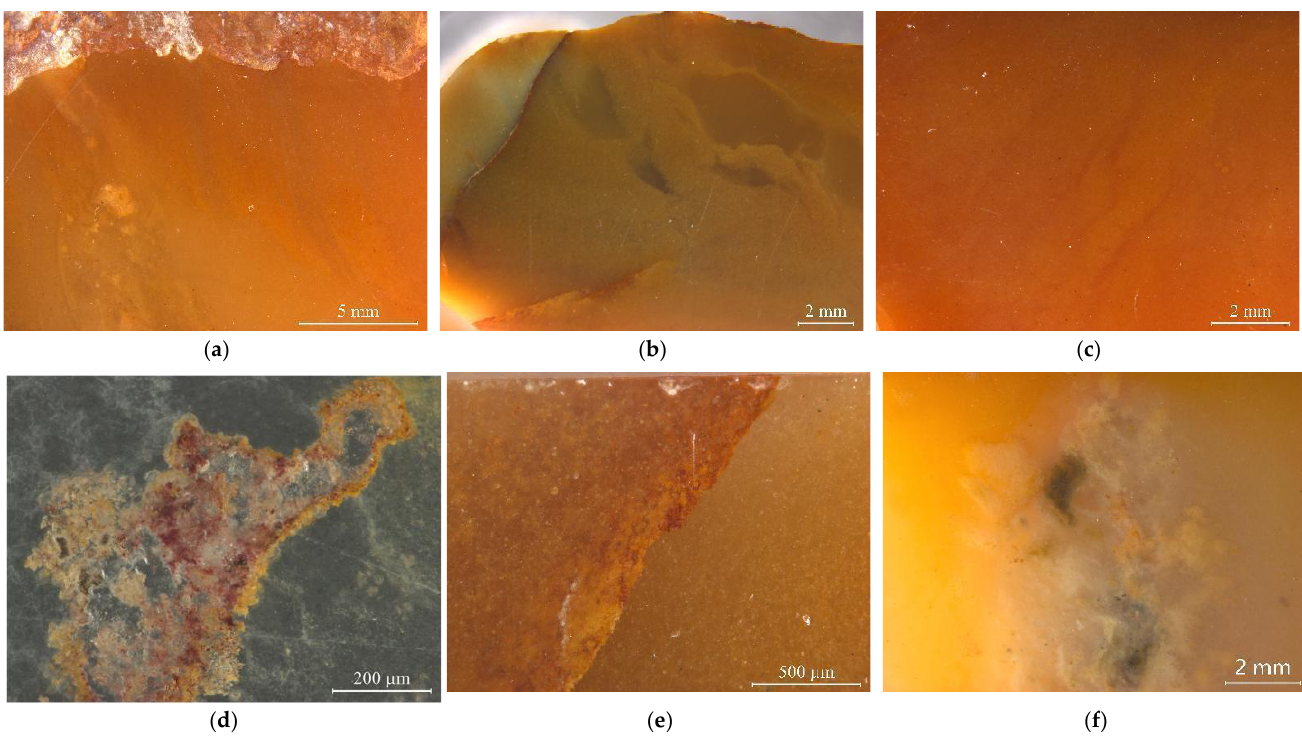
Figure 2. Colour distribution feature and impurity minerals in the samples. ( a ) orange-yellow to yellow from the outer to the inner part. ( b ) red cracks in the inhomogenous yellow matrix. ( c ) inho- mogeneous colour in the matrix. ( d ) pink spots in the matrix. Other minerals were also observed by further magnification. ( e ) dark red and yellow inclusions filled in the fracture. ( f ) irregularity of brown and grey impurities.